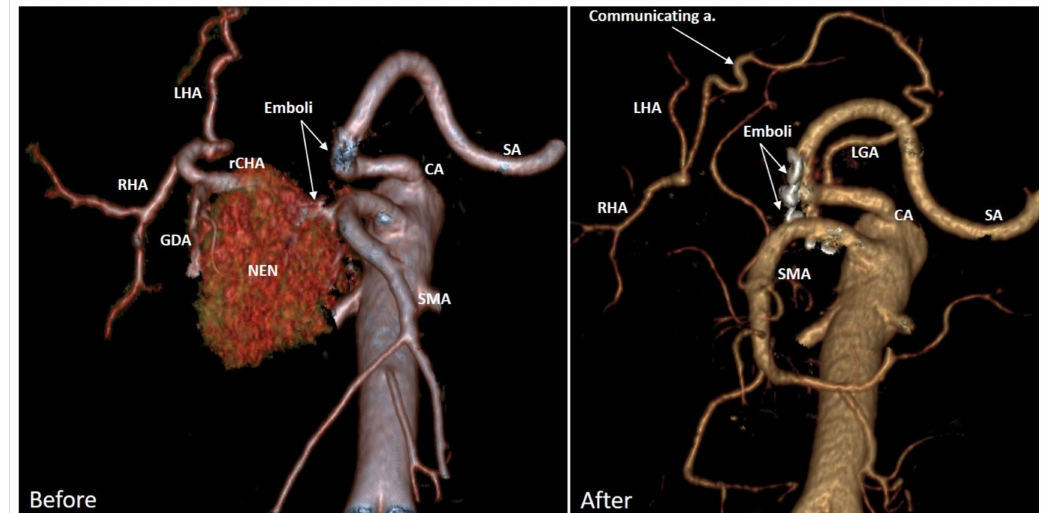
Figure 6. Neuroendocrine neoplasm (NEN) G2 of the pancreatic head in a 63-year-old female, complicated by the common hepatic artery invasion, massive recurrent intestinal bleedings, and recurrent embolizations. Three-dimensional CTA. Before surgery. Michels IX arterial anatomy with the replaced common hepatic (rCHA) originating from the superior mesenteric artery (SMA). A month after the Whipple procedure with excision of CHA. The liver is supplied from the celiac artery (CA) via the lesser curvature communicating arcade between the left gastric (LGA) and proper hepatic arteries. SA—splenic artery. This picture shows that liver arterial blood supply can be maintained by the collateral of much lesser diameter, which together with preserved LGA and/or SA makes PD arcade dilation hemodynamically unnecessary, i.e., expectations for the significant widening of the PD arcade after PO CHAE can fail due to the existence of alternative ways for the liver supply besides PDA, and these alternative collaterals can be excised during DP CAR (here there is the LC Arcade), i.e., PO CHAE, in this case, can be non-preventive for stomach and liver ischemia. RHA: right hepatic, SMA: superior mesenteric, LHA: left hepatic, CHA: common hepatic, SA: splenic, CA: celiac